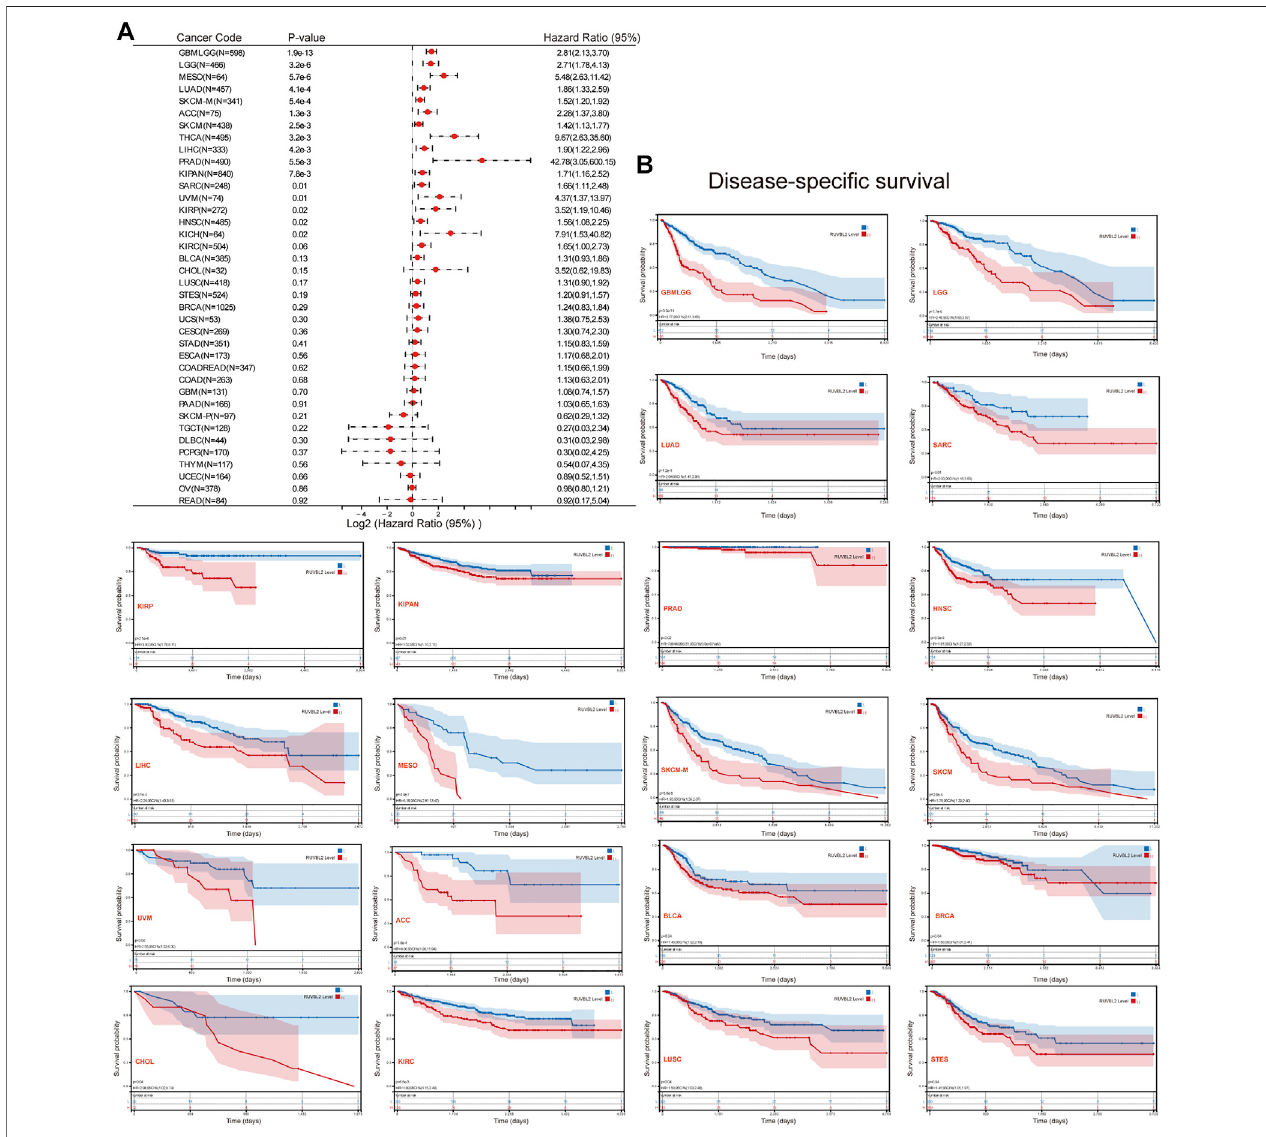
FIGURE3| PrognosisanalysisofReptininpan-cancer. (A) ForestplotoftheassociationsbetweenReptinandDSSin38typesoftumors. (B) Kaplan-Meiersurvival analysis of the relationship between Reptin and DSS. The positive results are shown.